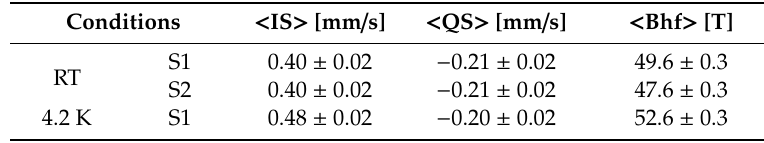
Figure 12. RT Mössbauer spectrum of the EC solid product prepared from leachate of EAFS*.